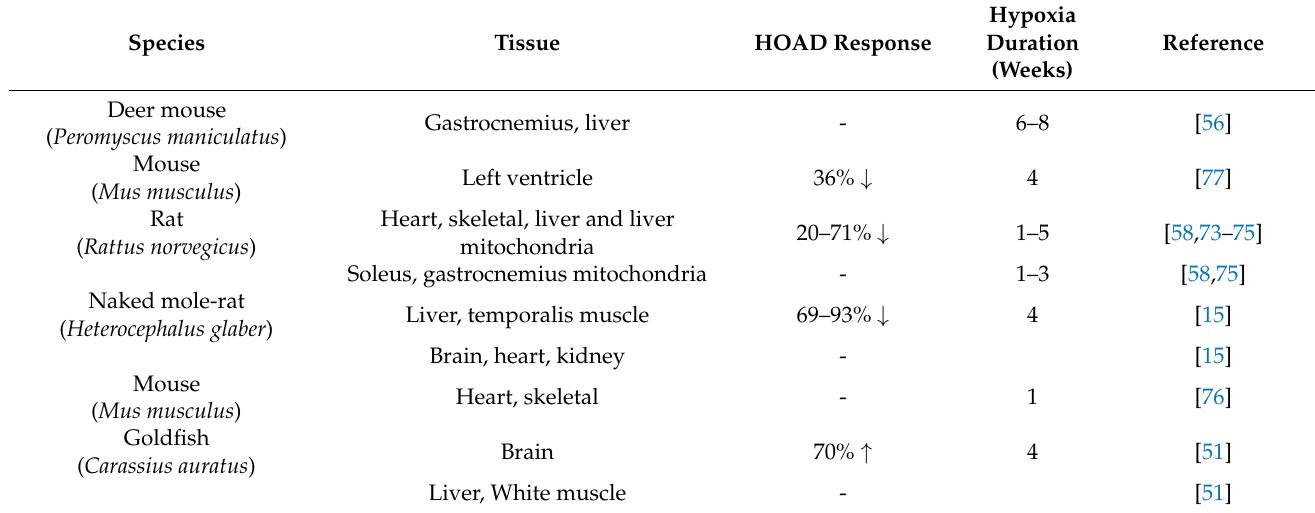
Table 7. Effects of chronic hypoxia (minimum 1 week) on the maximal activity of 3-hydroxyacyl-CoA dehydrogenase (HOAD) in various animals.